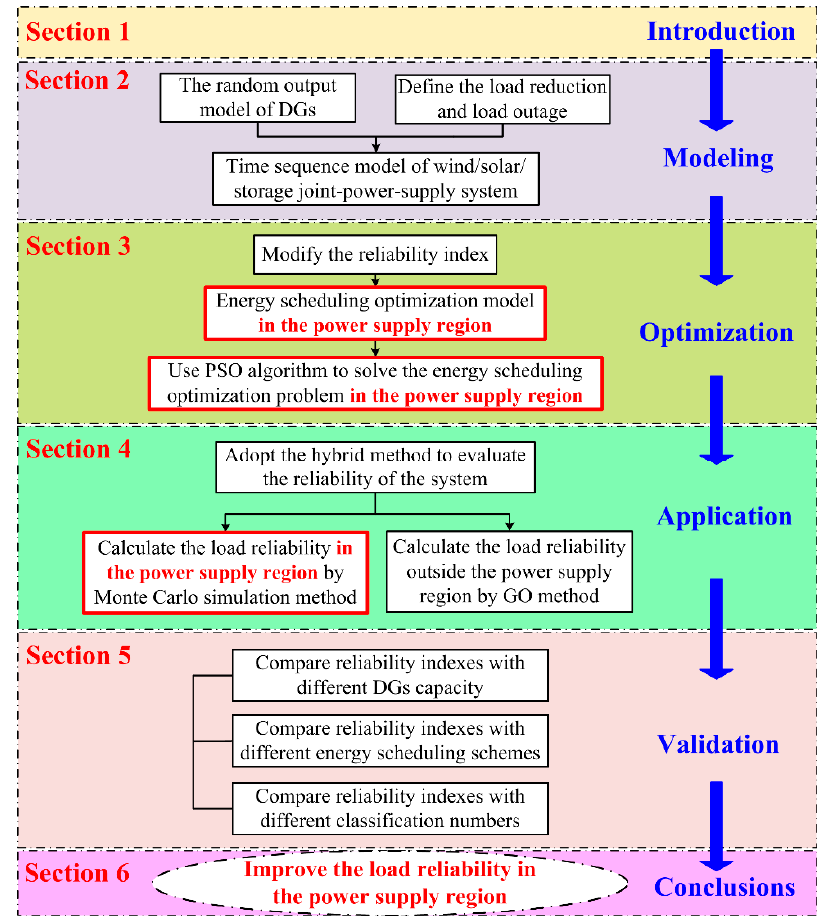
Figure 1. The structure flow chart of this paper.